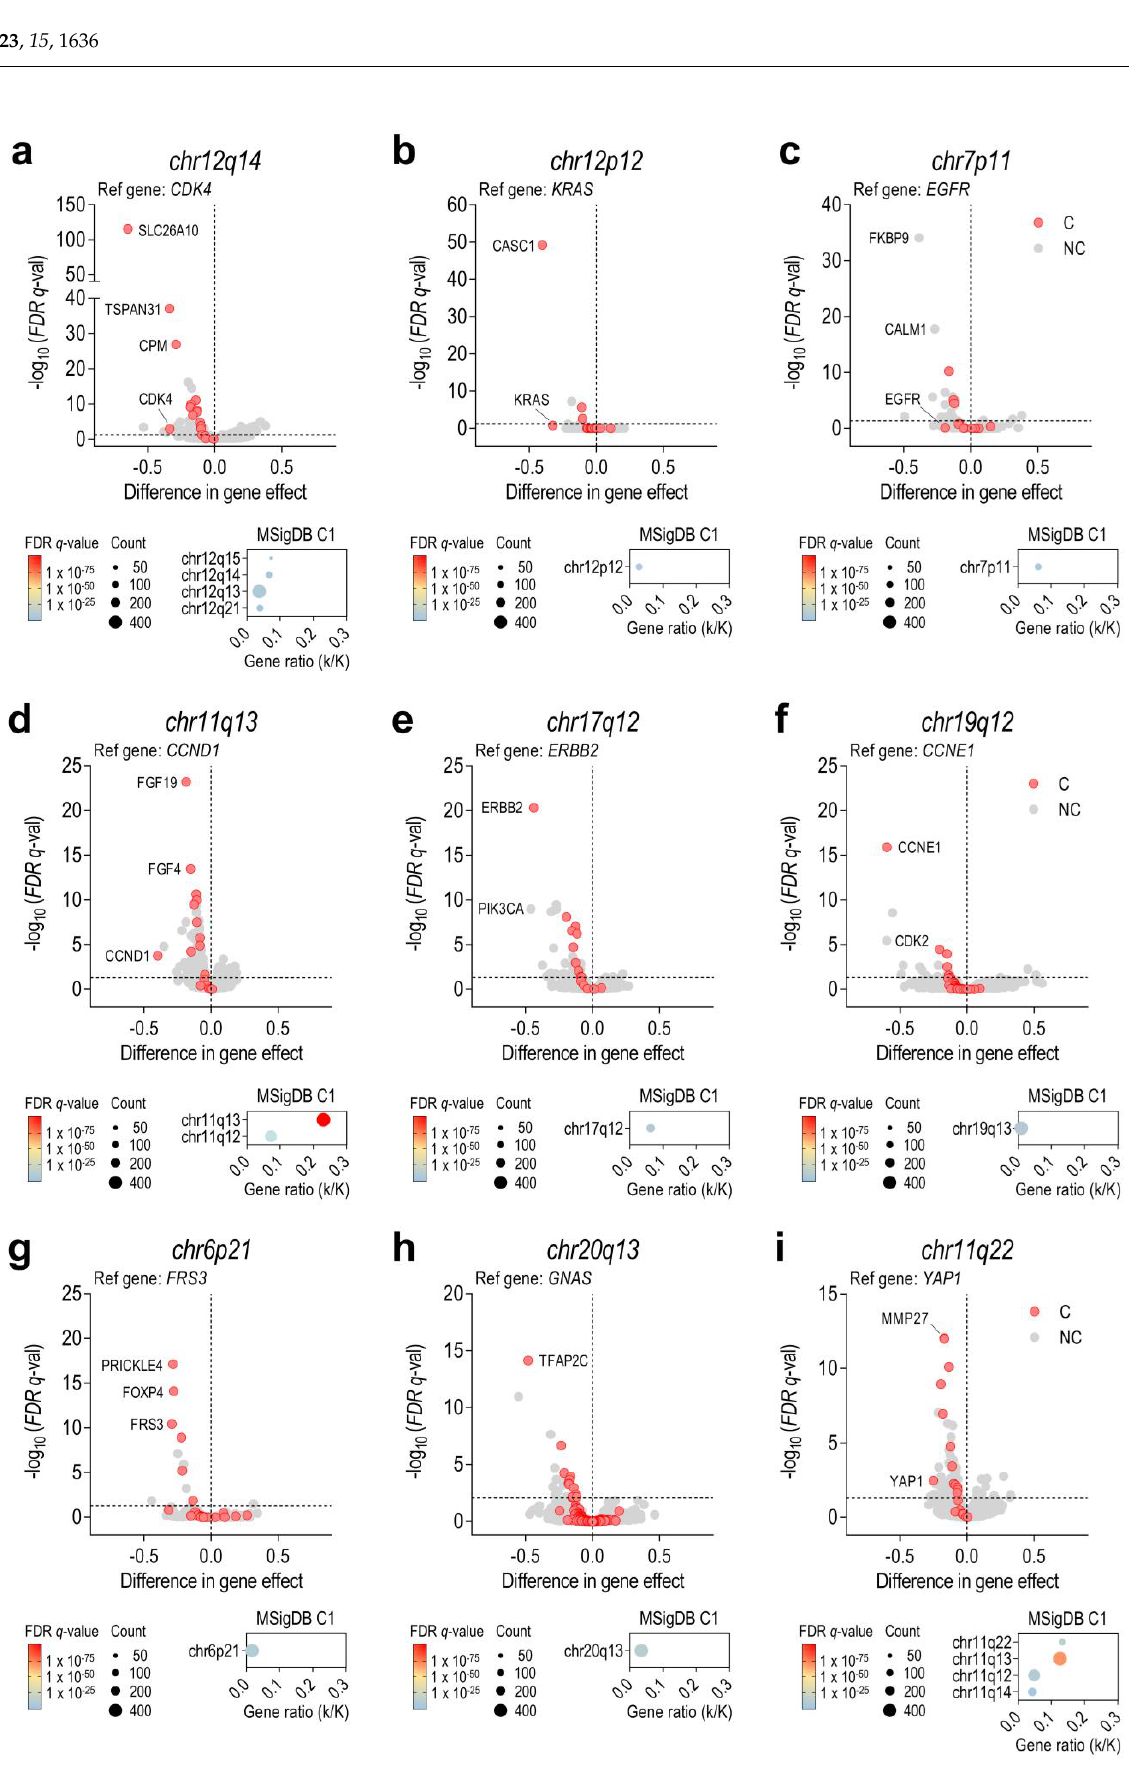
Figure 2. Identification of amplification-associated dependencies revealed the importance of coam- plified genes. Results are shown for the following amplifications: ( a ) CDK4 , chr12q14; ( b ) KRAS